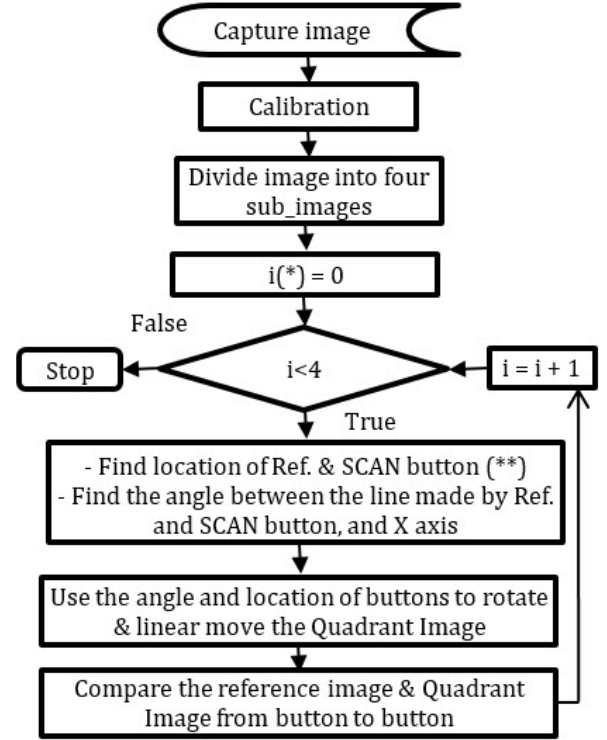
Figure 9. Flowchart of the automatic defect detection in mode 1. (*): i count order of image. (**): in this project, Ref. and SCAN buttons were defined as two fixed reference buttons defined by